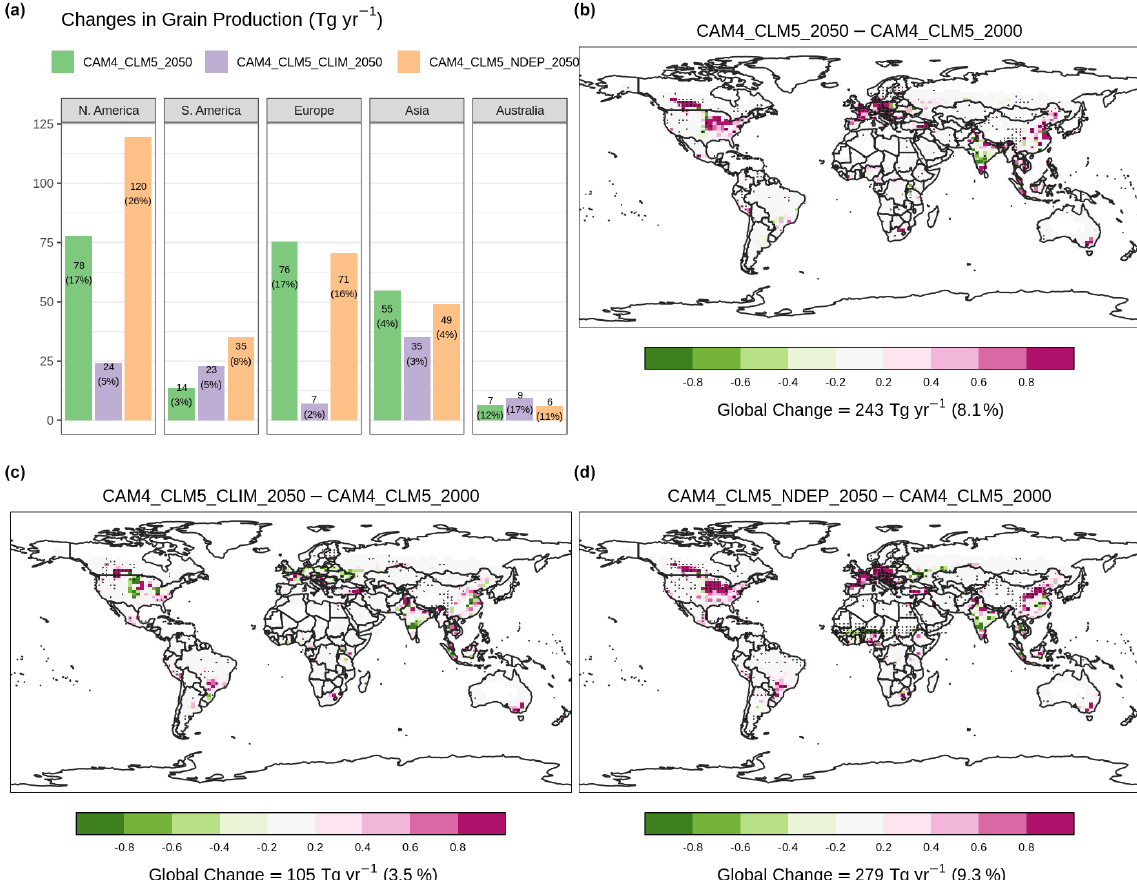
Figure 6. Same as Fig. 5 but for annual-total grain production (in teragrams of dry matter per year).